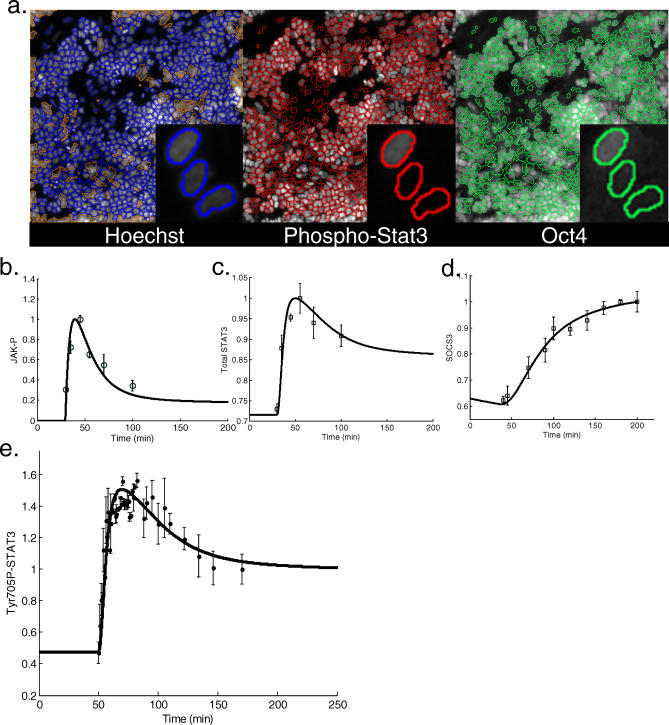
Experimental Validation of Model Output(A) Representative images of mouse ECS for quantitative single cell fluorescence microscopy. Hoechst nuclear stain is used to determine location of nuclei, a nuclear mask is drawn, and average fluorescence levels in the mask are used to determined levels of phosphorylated Stat3 and Oct4.(B–D) Show agreement between model-predicted trends and experimental results of activation profiles of Jak phosphorylation, nuclear retention of Stat3, and SOCS3 induction, respectively. For Jak phosphorylation, nuclear accumulation of Stat3, and SOCS3 induction, both experimental and simulation results were normalized based on the maximum of the activation profiles for each of these proteins. For nuclear accumulation of phosphorylated Stat3 the results were normalized based on a steady state level in 500 pM LIF.(E) The model-predicted activation profile of nuclear retention of Tyr-705 phosphorylated Stat3 is shown in solid line and is in agreement with experimental data points.